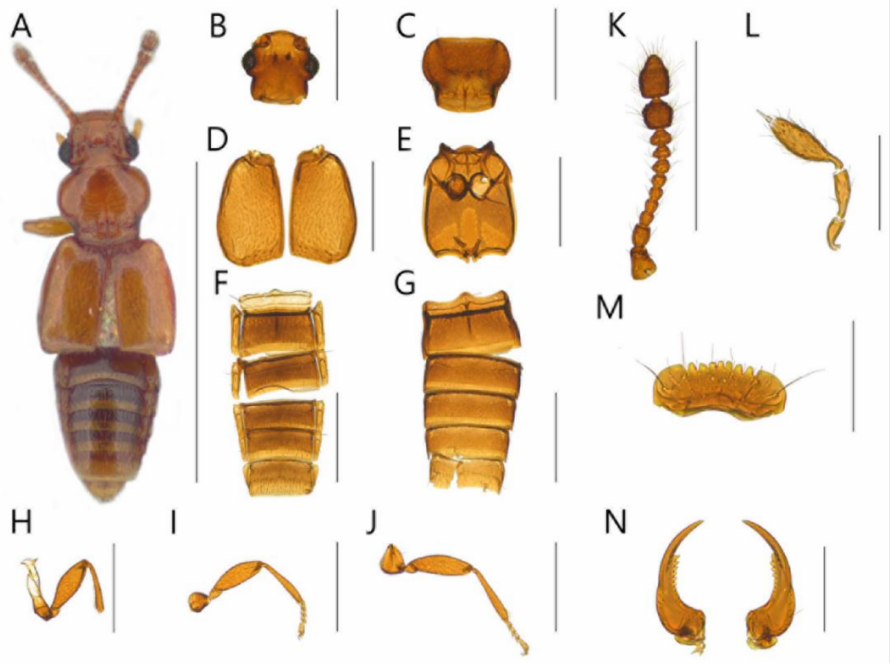
Figure 5. Male habitus of Edaphus ulsanensis sp.n.: ( A ) dorsal view; ( B ) head; ( C ) pronotum; ( D ) elytra; ( E ) meso and metasternum; ( F ) abdominal tergites; ( G ) abdominal sternites; ( H ) fore leg; ( I ) middle leg; ( J ) hind leg; ( K ) antennae; ( L ) maxillary palp; ( M ) labrum; ( N ) mandible. Scale bars: ( A ) = 1 mm; ( B – K ) = 0.3 mm; ( L – N ) = 0.1 mm.